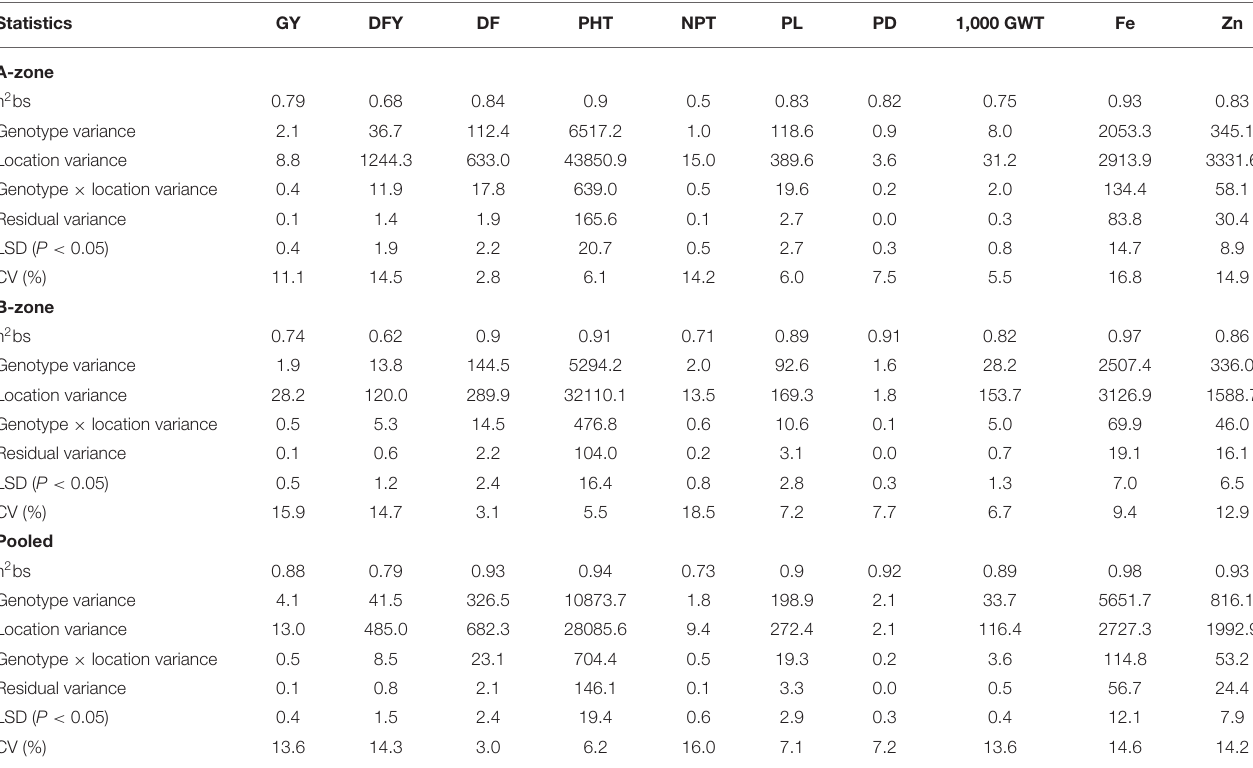
TABLE 3 | Estimation of variance components and broad sense heritability (h 2 bs) for yield, quality, and agronomic traits in A-zone, B-zone, and across all locations in